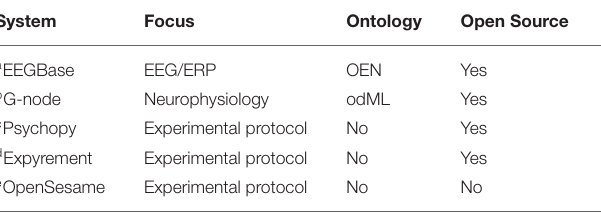
TABLE 1 | Software tools for neuroscience experiments